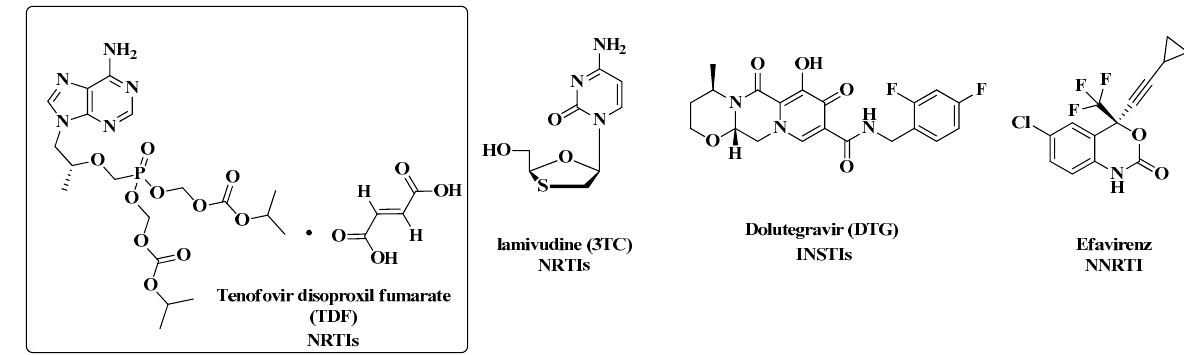
Figure 2. Chemical structure of the main antiretroviral drugs currently used in AIDS therapy.